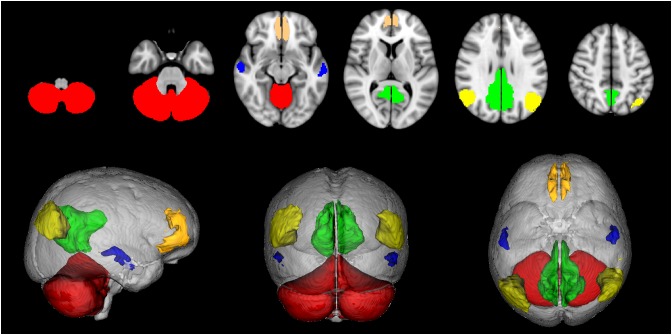
Default mode network (DMN) nodes. Medial frontal cortex (orange), angular gyri (yellow), precuneus/posterior cingulate cortex (green), middle temporal gyri (blue), cerebellum (red).